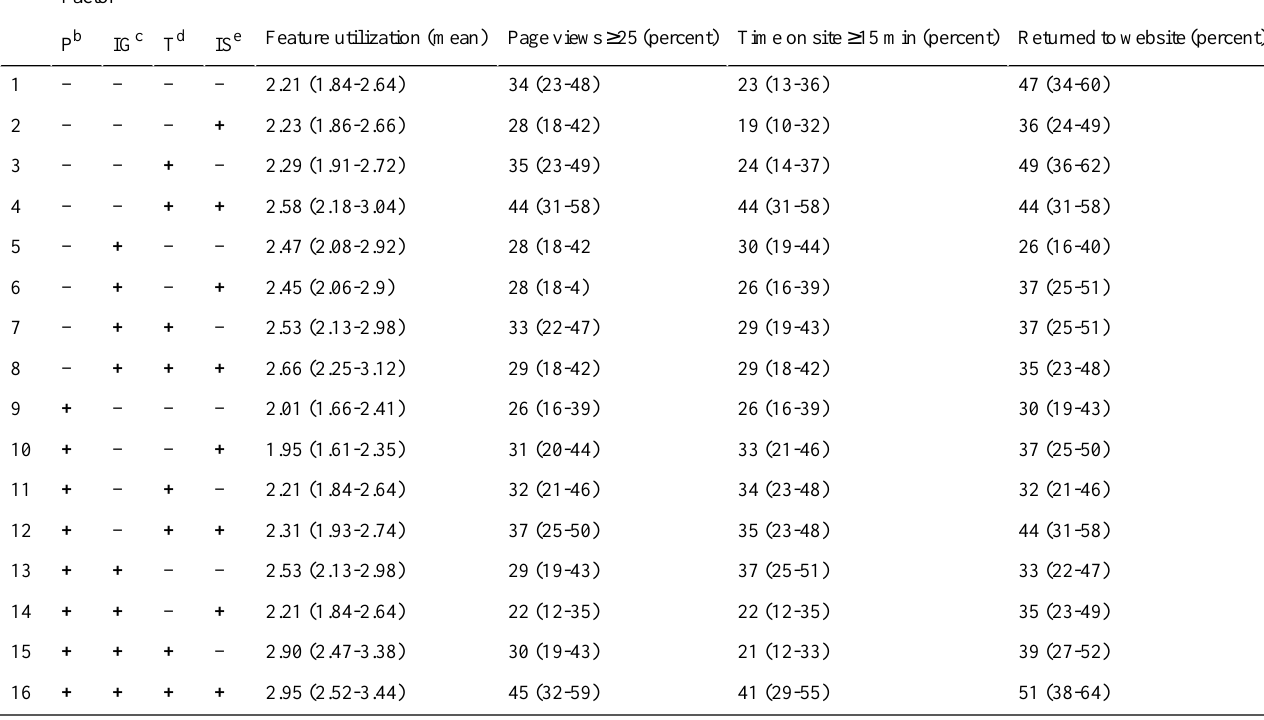
Key Engagement MetricFactor a